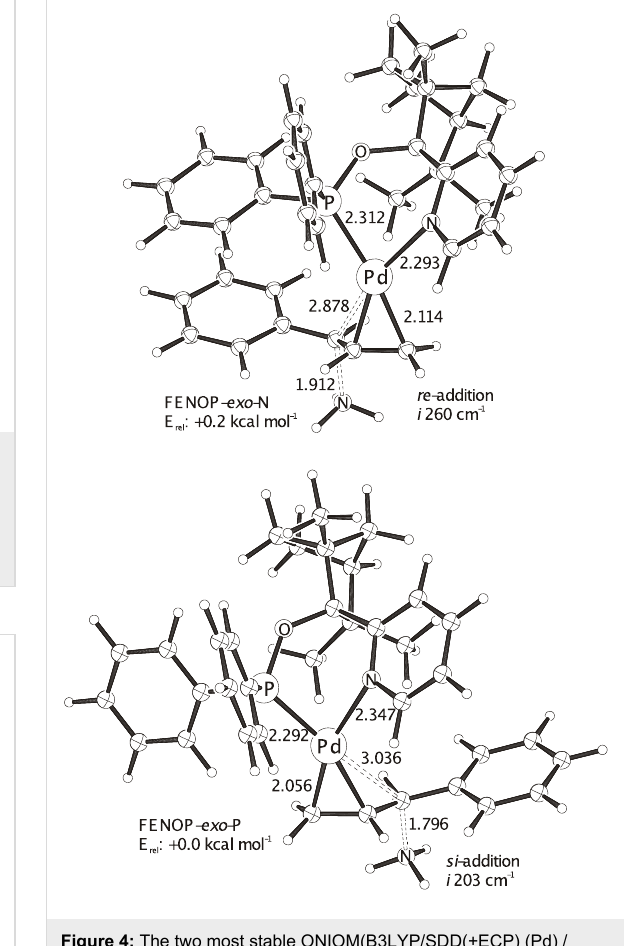
Figure 4: The two most stable ONIOM(B3LYP/SDD(+ECP) (Pd) / 6-31G* (C, H, O, N, P) : UFF) optimized transition structures with FENOP . ZPE (unscaled) corrected total extrapolated energies: FENOP- exo -N ( re ): -1236.56193 H, FENOP- exo -P ( si ):